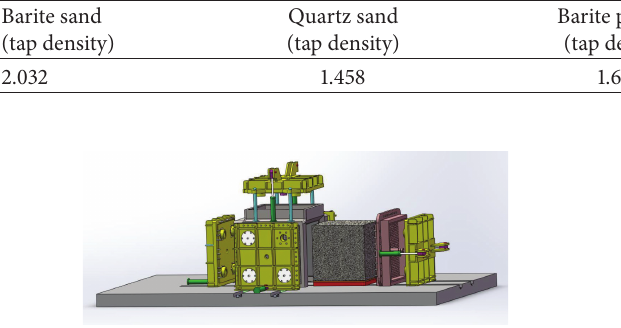
Figure 2: The schematic diagram of the model test system and underground model.